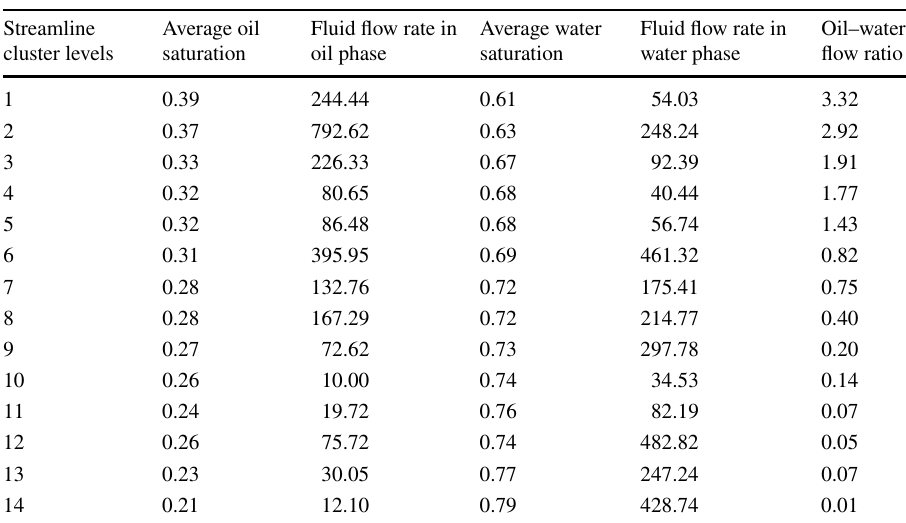
Table 2 Streamline attribute statistics with different